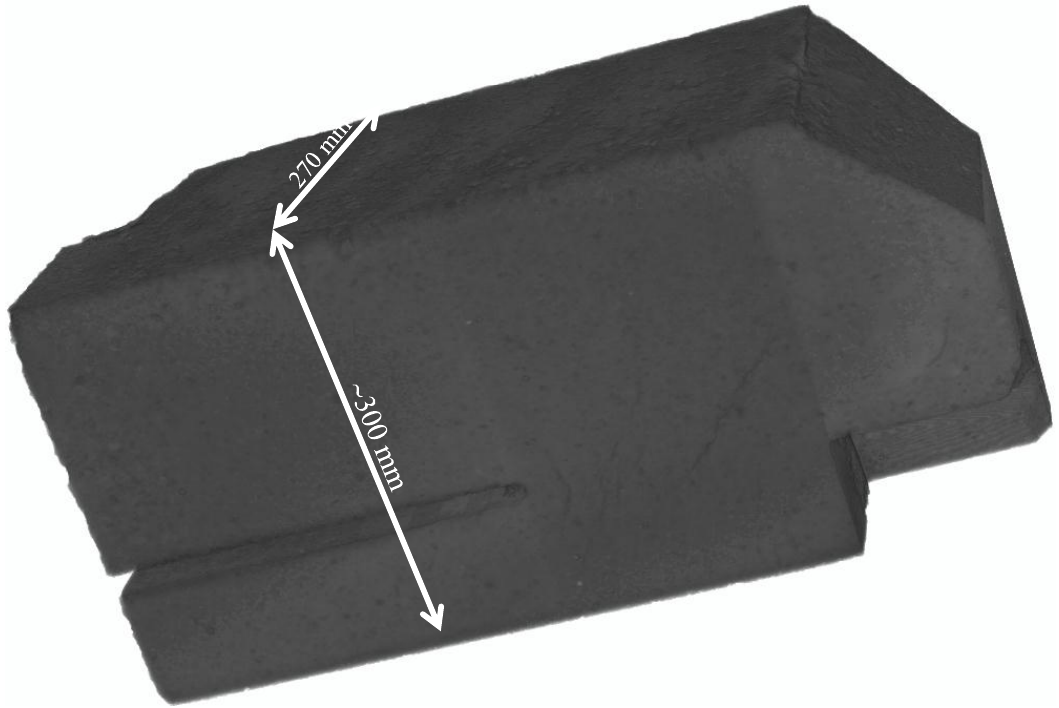
Figure 11. Partial anode block.